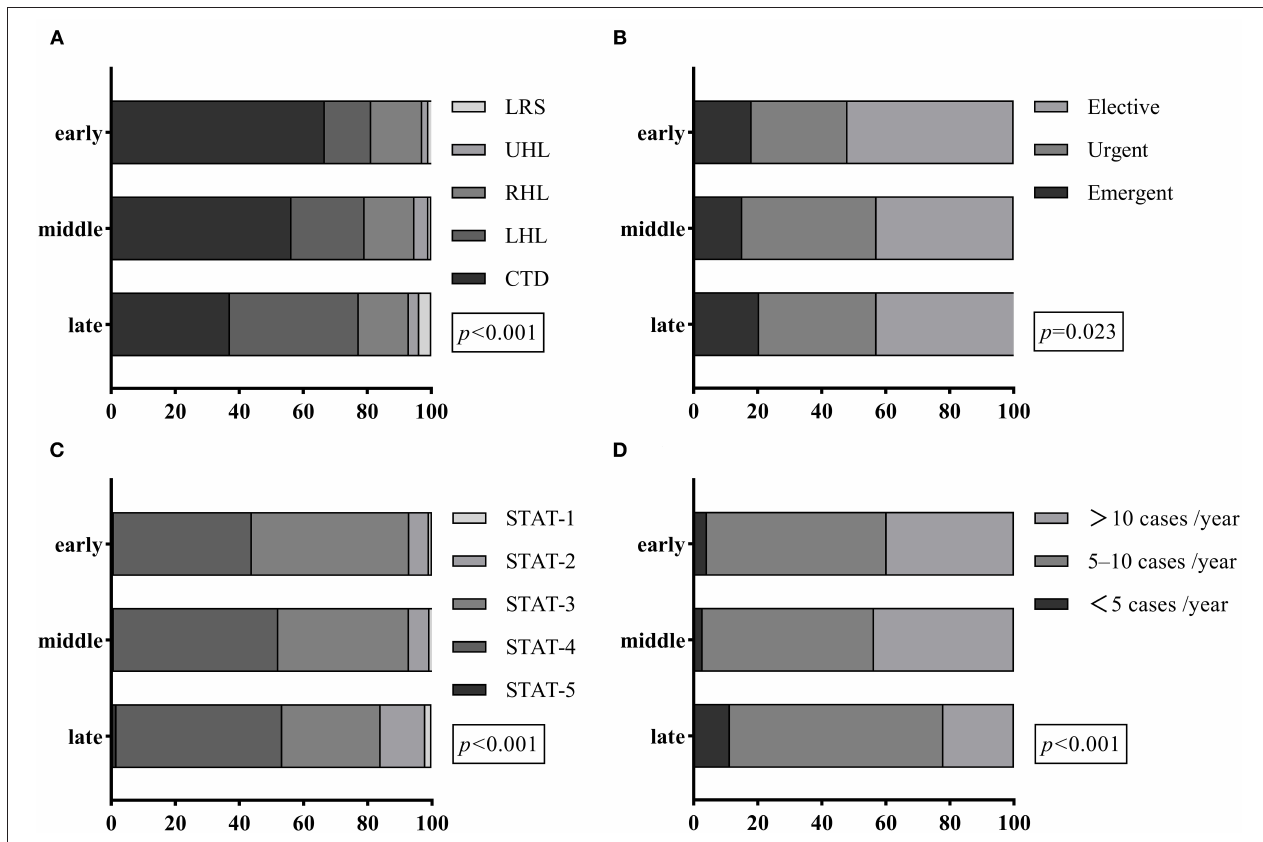
FIGURE 2 | Trend analysis for the prevalence of primary diagnosis (A) , health status (B) , STAT category (C) , and surgeon experience (D) in different surgical eras. CTD, conotruncal defects; LHL, left heart lesions; LRS, left to right shunt; RHL, right heart lesions; STAT, Society of Thoracic Surgeons-European Association for Cardio-Thoracic Surgery; UHL, univentricular heart lesions.